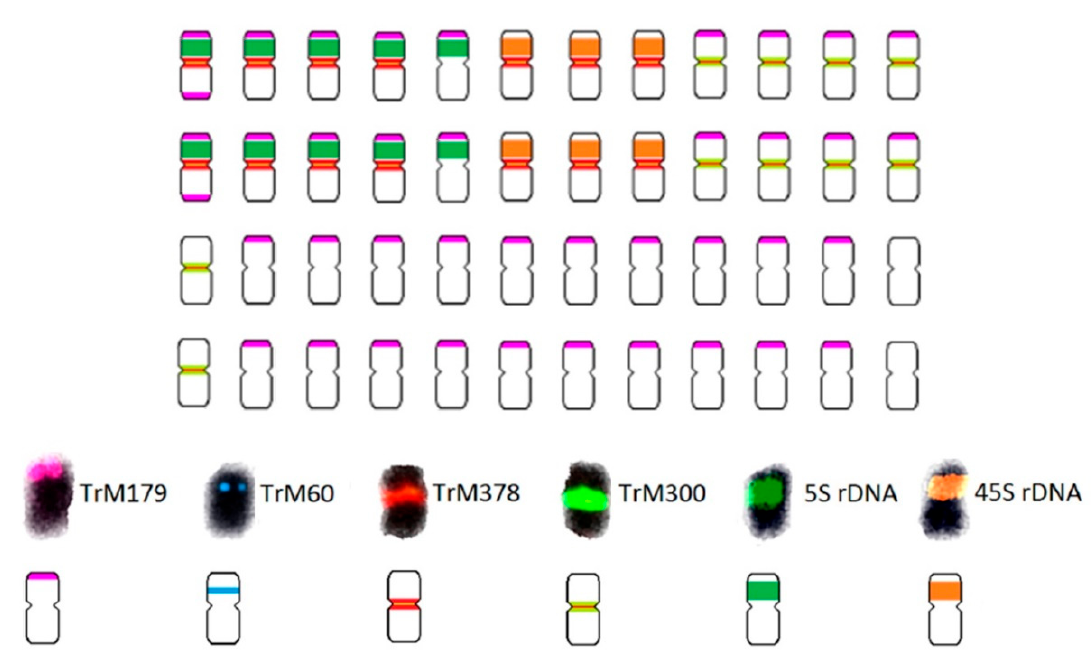
Figure 5. Schematic karyotype of T. medium var. sarosiense based on the hybridization pattern of probes derived from 5S (dark green) and 26S (orange) rDNA, subtelomeric repeat TrM179 (pink), pericentromeric repeat TrM60 (blue), and two centromeric repeats TrM378 (red) and TrM300 (light green). The ideogram illustrates numbers and mutual localizations of analysed cytogenetic markers only schematically and does not precisely capture specific chromosomal localization of each locus.